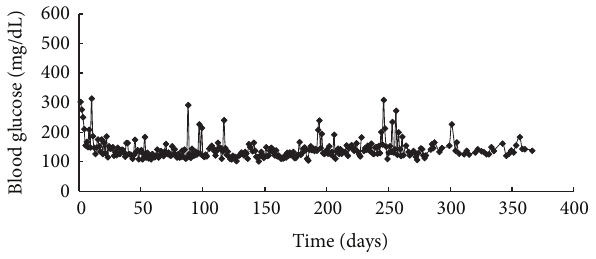
Figure 6: One spontaneous diabetic NOD mouse achieved nor- moglycemia 10 days after ATRA treatment but then had occasional hyperglycemia between 88 and 366